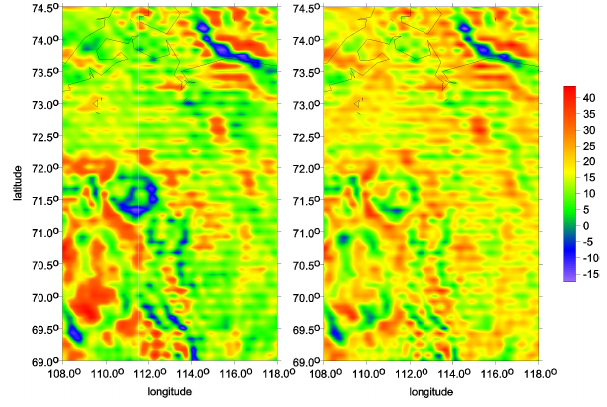
Fig. 10. (a)–(b) : The second radial derivatives [E] without the low or lower portion of the harmonic coefficients – panel (a) (left) with- out those coefficients to degree and order 36, panel (b) (right) with- out those to degree and order 360, based on